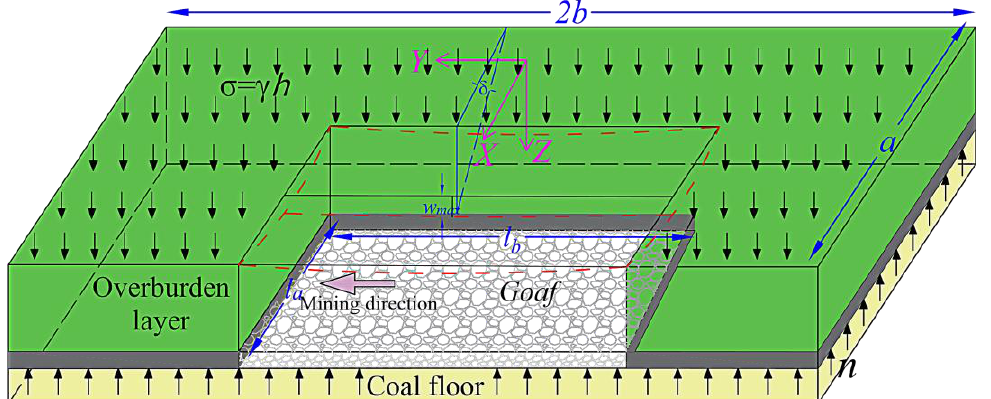
Figure 2. Mechanical model of the plate